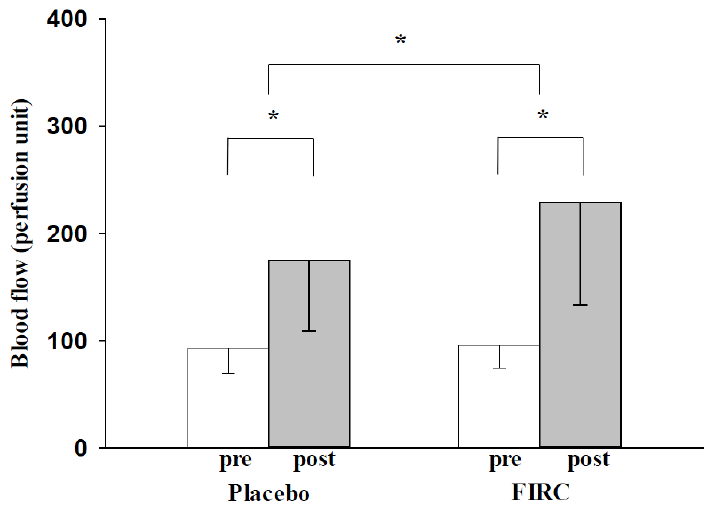
Figure 3. Changes in blood flow of placebo and FIRC groups before and after intervention. Asterisk indicates a significant difference.